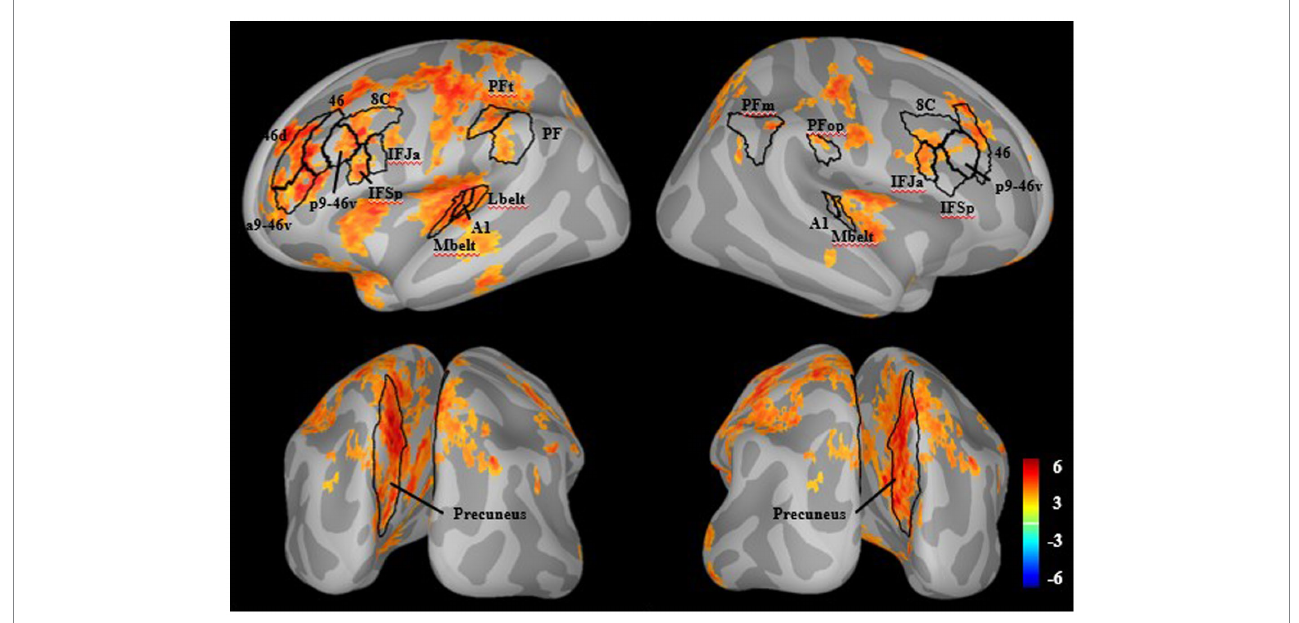
FIGURE 1 Whole-brain M100 modulation in healthy individuals. There were significant increases in source-resolved MEG activity (dspm) with attention compared to ignore in healthy individuals ( q < 0.05). Outlined in black are regions aligning with the general hypothesized network including prefrontal, posterior parietal, precuneus, and auditory cortices.